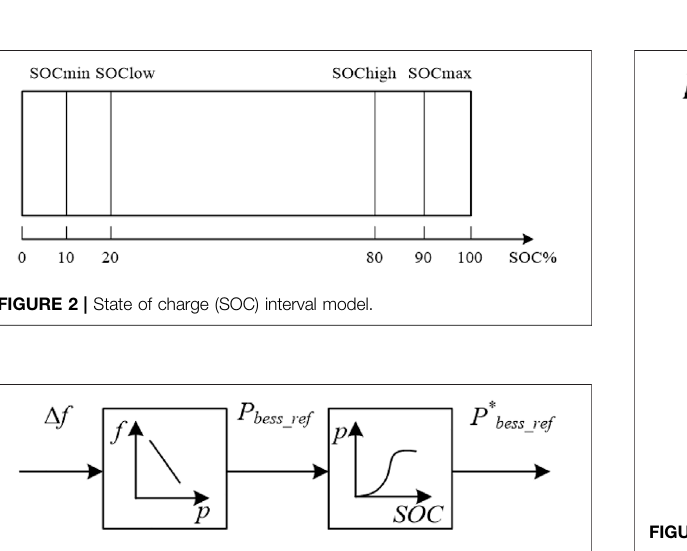
FIGURE 3 | SOC-based frequency droop control for battery energy storage system (BESS).